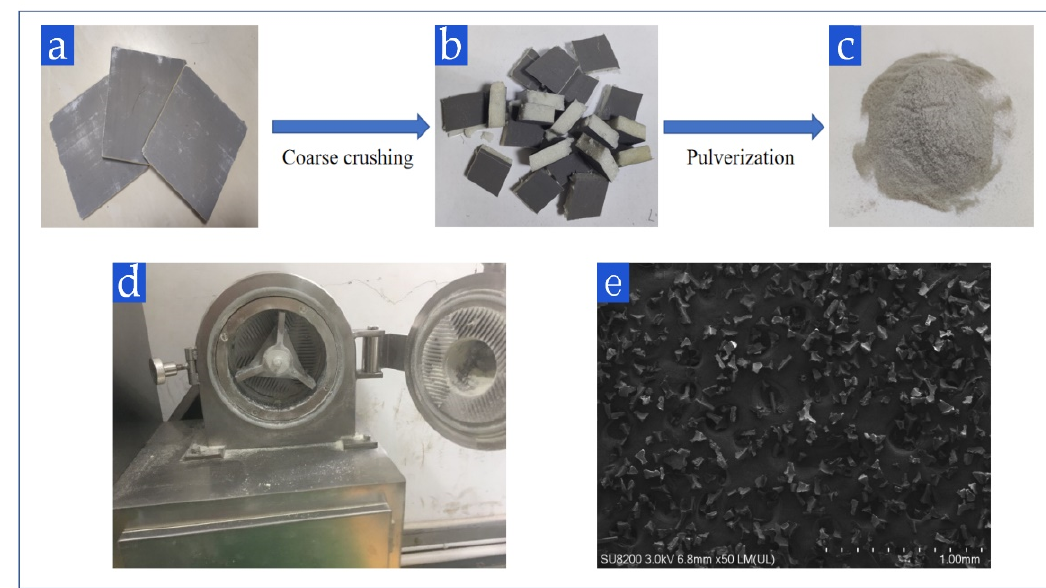
Figure 2. Appearance of ( a ) Waste PUF board, ( b ) PUF pieces, ( c ) PUF powder, ( d ) self-made crusher, and ( e ) microscopic morphology of PUF powder.